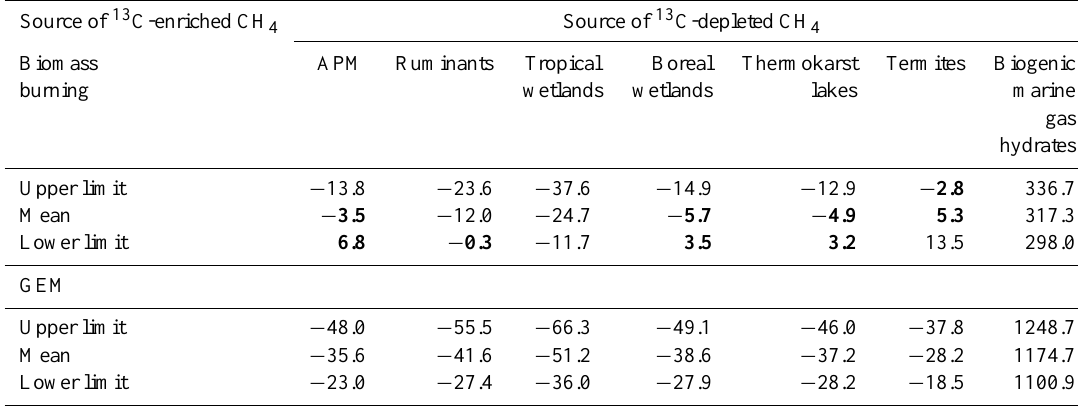
Table 4. δ 13 CH 4 and δ D-CH 4 mass balance results for scenarios with biomass burning and geologic emissions of methane as the 13 C- enriched contributing source. Results are presented as percent mismatch between the fractional source contributions calculated independently by the δ 13 CH 4 and the δ D-CH 4 mass balances (methodology is further described in Sect. 3.5.2.). The characteristic source and sink isotope values and source fractional strengths are for the standard scenario as in the triple mass balance (see Tables 1 and 2). The mean percent mismatch is calculated using mean δ 13 CH 4 ↑ T ( − 49.2‰) and δ D-CH 4 ↑ T ( − 314‰) values. Also presented are the minimums and maxi- mums in percent mismatches between the mass balances for the range of δ 13 CH 4 ↑ T (1.3‰) and δ D-CH 4 ↑ T (8‰) values (see Sect. 3.3). From this uncertainty range, the upper limit in percent mismatch values is consistently given by the constraint of a δ D-CH 4 ↑ T value of − 322‰ and δ 13 CH ↑ T value of − 47.9‰. The lower limit is consistently given by the constraints of a δ D-CH ↑ T value of − 306‰ and 4 4 a δ 13 CH 4 ↑ T value of − 50.4‰. All percent mismatch values less than 10% (similar to the criteria for an acceptable scenario in the triple mass balance; see Sec. 3.3) are considered valid scenarios and are highlighted in bold